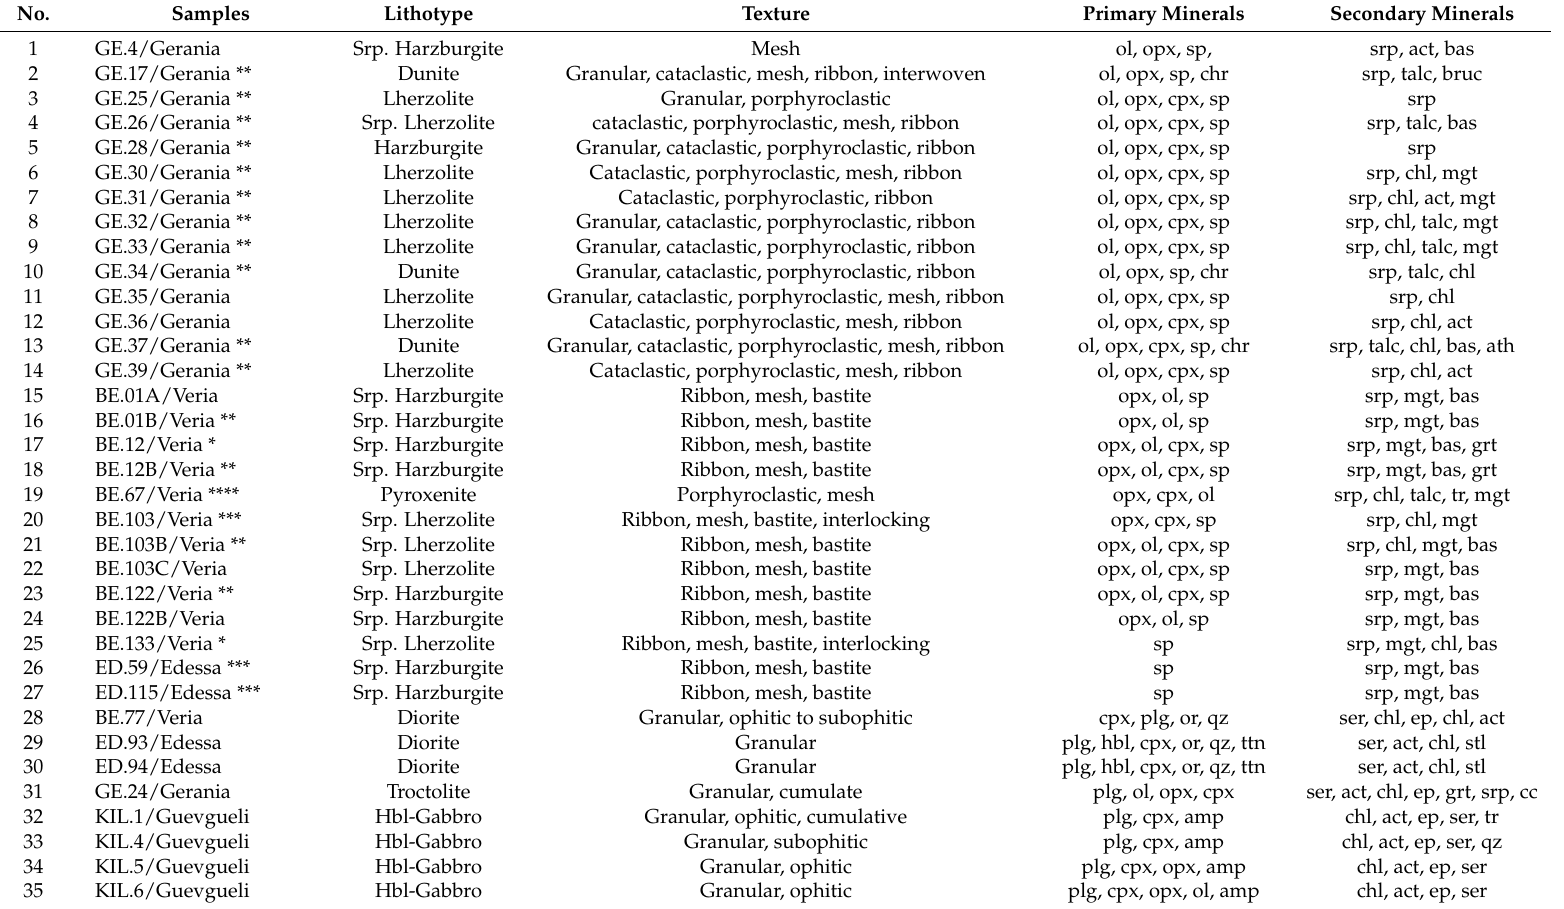
Table 1. Petrographic characteristics of the studied igneous